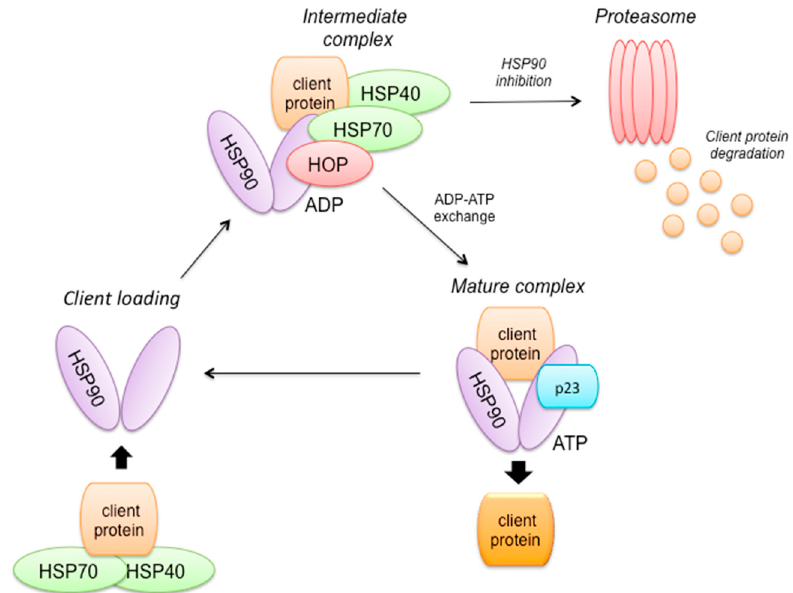
Figure 3. HSP90 mechanism of action. The binding of a client protein to HSP90 requires the co-operation of another chaperone (HSP70 and its co-factor HSP40). HOP mediates interaction between HSP70 and HSP90. The exchange of ADP to ATP induces dissociation of HSP70 and its co-chaperones from the complex that associate then with p23, forming a mature complex. Under stressful conditions, HSP90 protects oncoproteins (such as HER2, AKT, c-MYC, etc.) from degradation. HSP90: heat shock protein 90 kDa, HSP70: Heat-shock protein of 70-kDa, HSP40: heat shock protein 40 kDA, HOP: Hsp organizing protein, ADP: Adenosine diphosphate, ATP: Adenosine triphosphate.